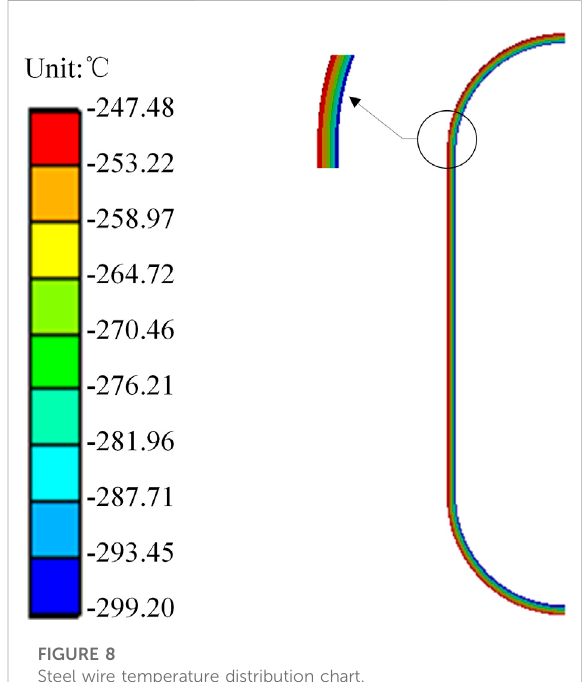
FIGURE 8 Steel wire temperature distribution